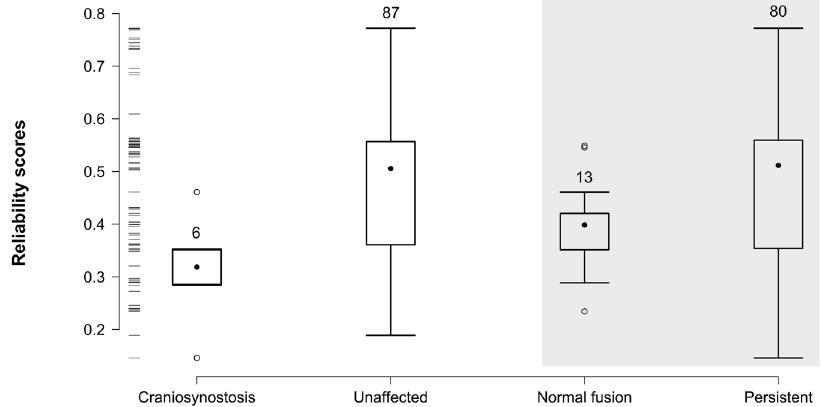
Figure 2. Box plot comparing link reliability scores. Articulations associated with craniosynostosis have lower reliability than those that are not associated ( left , white panel). Articulations that close during normal development also have lower reliability than those that will persist in the adult live ( right , gray